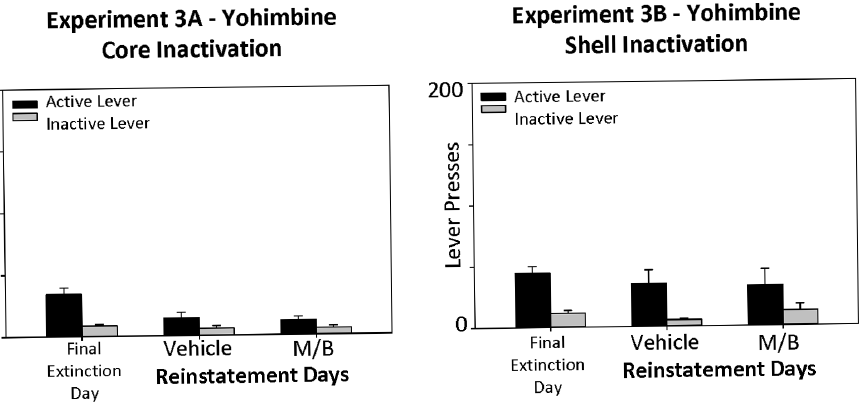
Figure 5. Rats tested for reinstatement following injections of the pharmacological stressor yohimbine did not reinstate food- seeking behavior. As can be seen, there was no increase in lever pressing following yohimbine, even on the day that rats were tested with saline vehicle injections into either the NAcc shell or core.